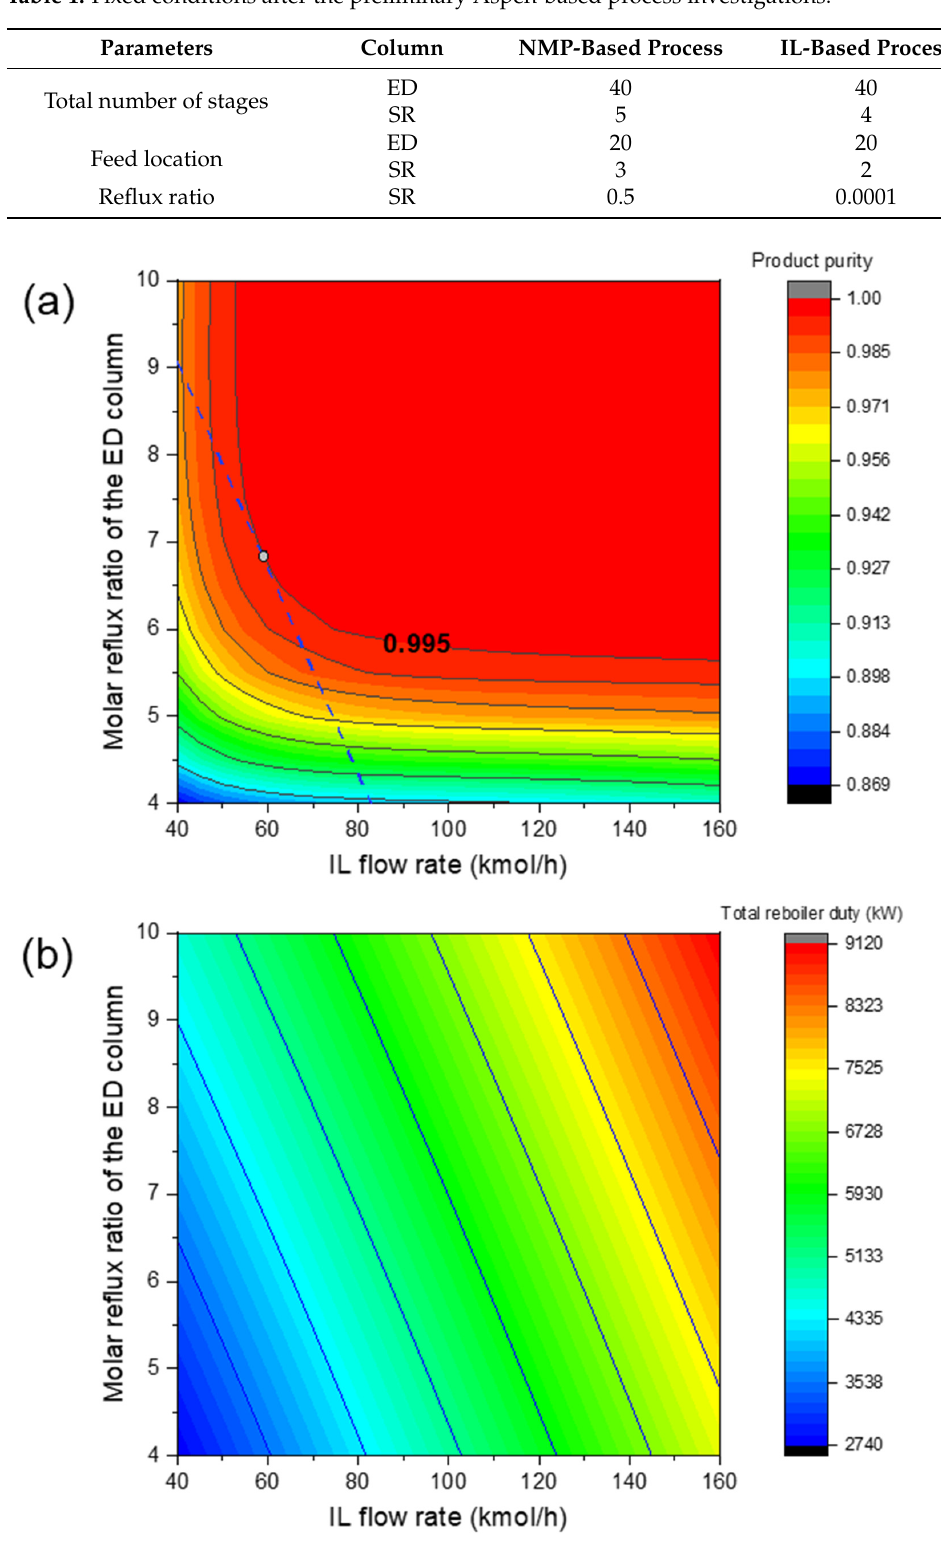
Figure 5. Influence of reflux ratio of the ED column and solvent usage on ( a ) product purity and ( b ) total reboiler duty for the IL-based process.